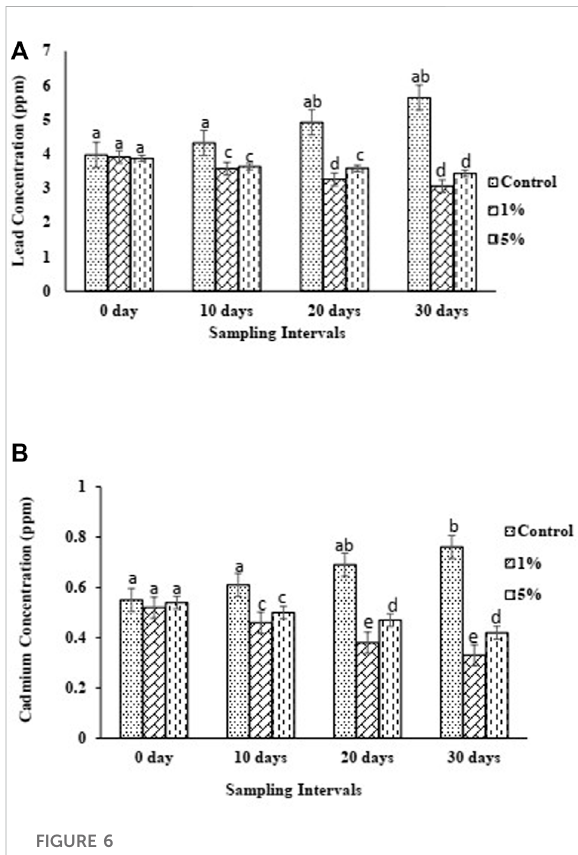
FIGURE 6 (A) Lead (Pb) concentration (B) Cadmium (Cd) trend of control and biochar amended soils over 1 month